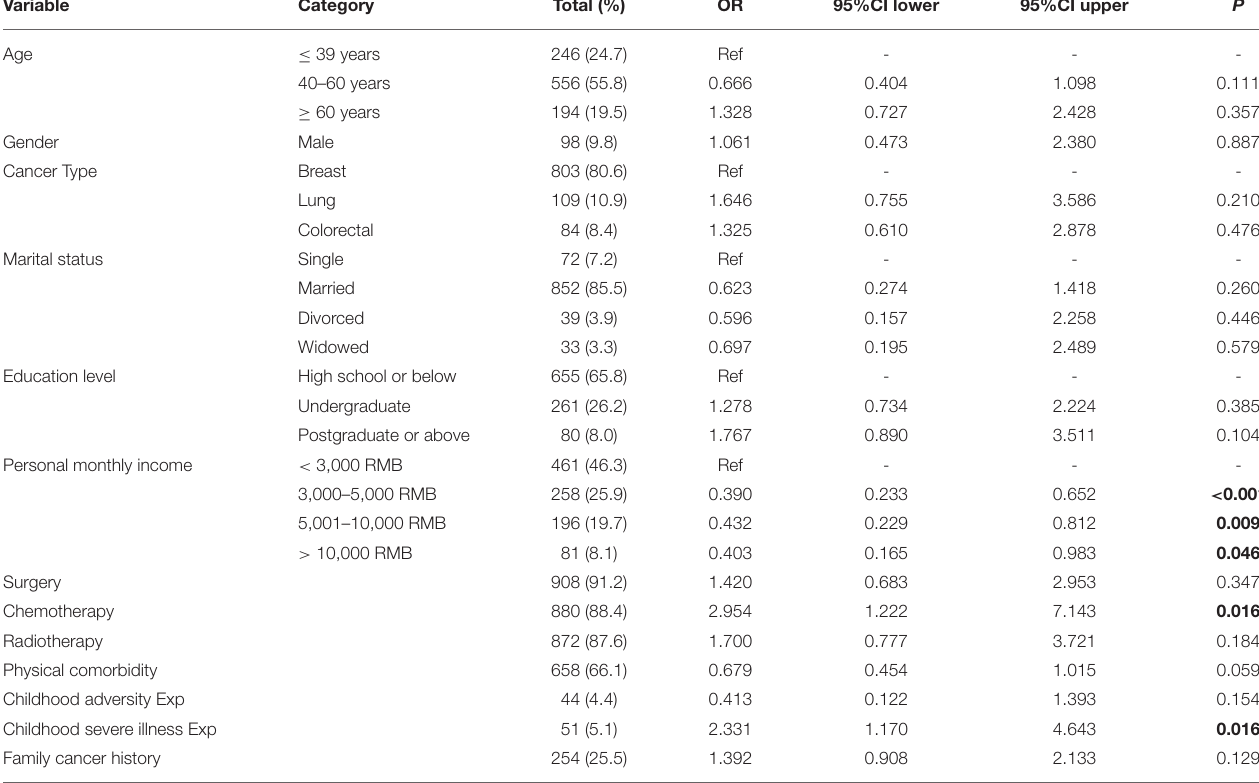
TABLE 1 | Multivariate logistic regression of variables associated with high FCR.